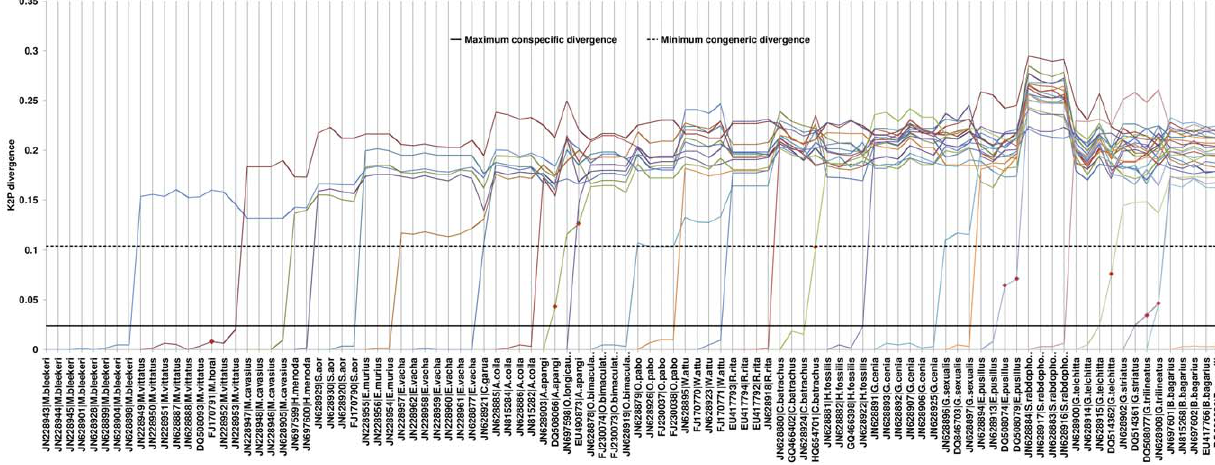
Figure 2. Congeneric and conspecific K2P divergence for 101 sequences of 27 catfish species. The maximum conspecific divergence (0.024, black solid line) and minimum congeneric divergence (0.104, black dotted line) represent the threshold level of conspecific and congeneric divergence respectively. Most of the studied species (21) obeyed the thresholds and are readily delineated showing barcoding gap of 4.33 or above. Sequences of species like M. horai (accession number FJ170791), B. yarrelli (accession number DG508069), A. apangi (accession numbers EU490873 and DQ508066), C. batrachus (accession number HQ654701), E. pusillus (accession numbers DQ508074 and DQ508079), G. telchitta (accession number DQ514362), G. trilineatus (accession number DQ508077) did not obey the thresholds and are thus ambiguous (shown in red dots). G. striatus with two sequences obeyed the threshold of maximum conspecific divergence and minimum congeneric divergence with all congeners except G. trilineatus. ? In the X-axis the specimens involved in this study were plotted and marked as, GenBank accession number|species